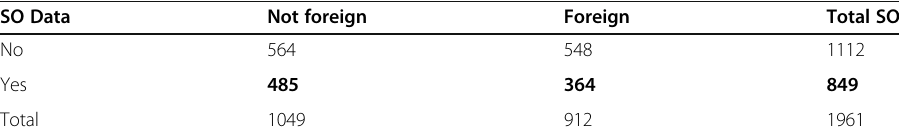
Table 1 Original distribution of the sample in LCS SO Data Not foreign